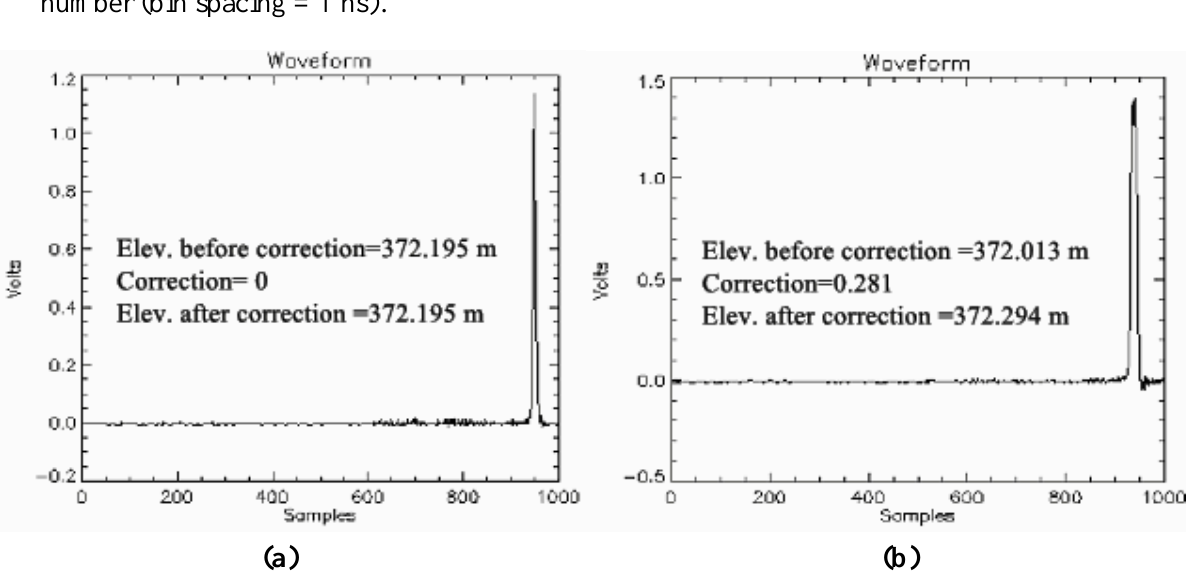
Figure 2. Typical Geoscience Laser Altimeter System (GLAS) waveforms on Lake Leman (water only). ( a ) Unsaturated waveform, ( b ) waveform slightly saturated, and ( c , d ) waveforms with high saturation. These examples are extracted from the 03 June 2005 transect. The reference elevation is 372.18 m. Ordinate = energy in volts and abscissa = bin number (bin spacing = 1